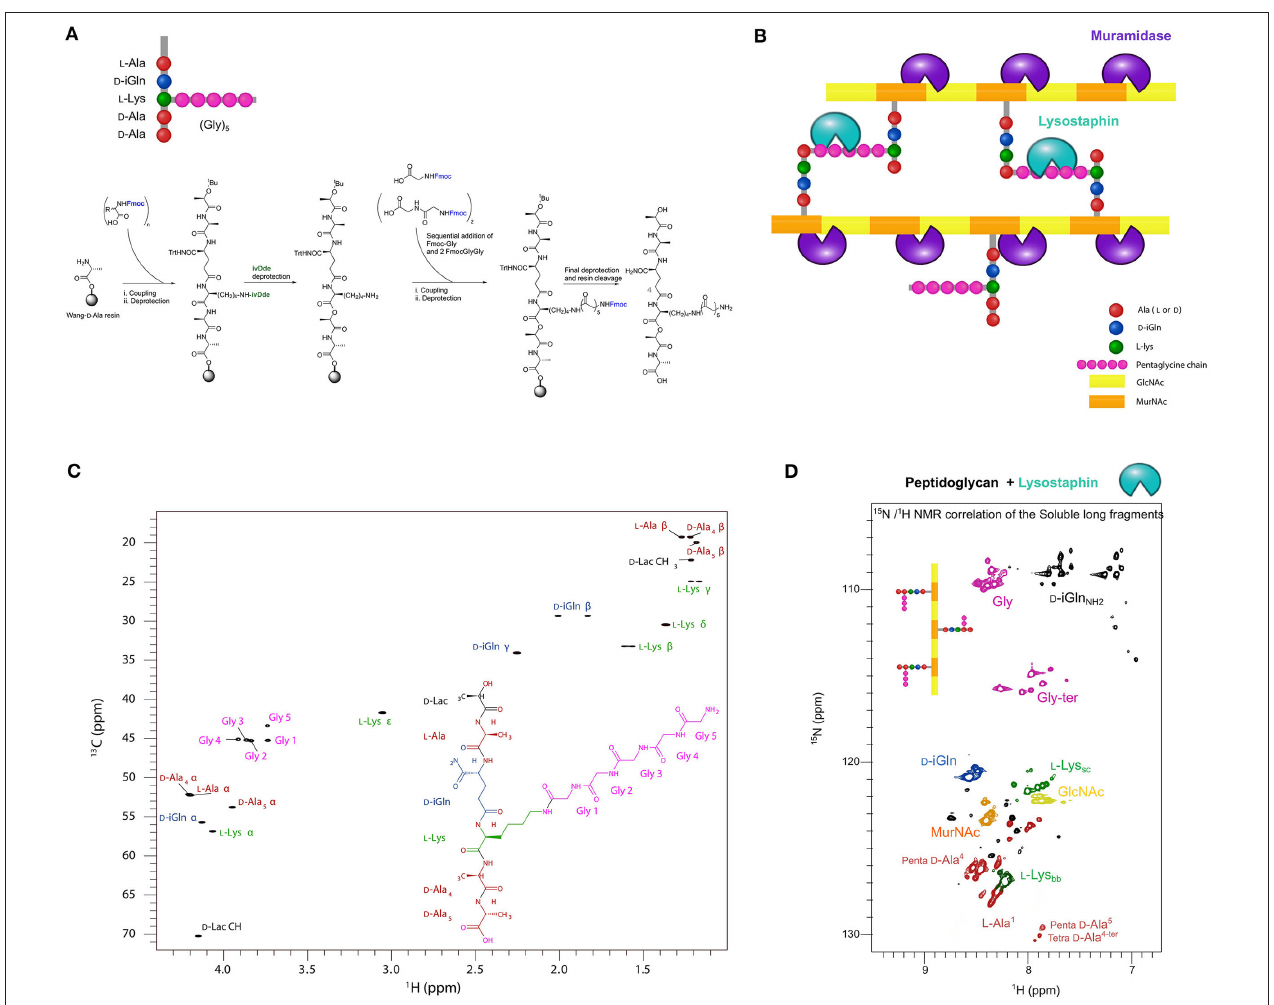
FIGURE 2 | Preparation and NMR spectroscopy of PG fragments (A) Scheme of the synthetic route to branched lactoyl-peptides. Wang-D-Ala resin was obtained by Fmoc deprotection of the commercially available functionalized solid-phase support for peptide synthesis. Protecting groups: Fmoc, fluorenylmethoxycarbonyl; Trt, trityl; IvDde, 1-(4,4-dimethyl-2,6-dioxocyclohexylidene)-3-methylbutyl. (B) Scheme of the PG structure showing the cleavage sites of the muramidase cellosyl (purple) and the endopeptidase lysostaphin (green). (C) 1 H, 13 C-correlation NMR spectrum ( 13 C-HSQC) collected at 20 ◦ C on a 2.3mM sample of HO-D-Lac-L-Ala-D-iGln-L-Lys(Gly) 5 -D-Ala-D-Ala-COOH pentapeptide in 50mM potassium phosphate buffer, pH 6.5 containing 10% D 2 O. (D) 1 H, 15 N-correlation NMR spectrum ( 15 N-HSQC) of a ∼ 500 µ M solution of PG fragments obtained by digestion with lysostaphin of PG from S. aureus SH1000 grown in